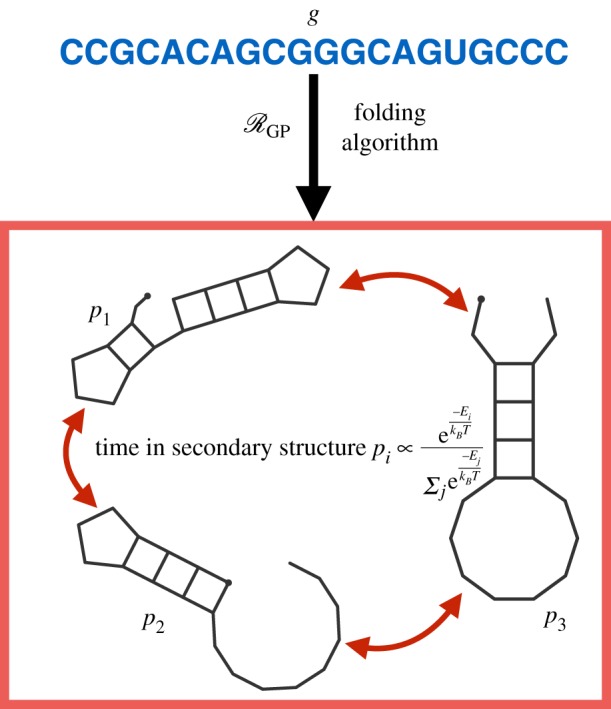
The stochastic RNA model. Thermal fluctuations cause RNA strands to spontaneously unfold and fold again into different secondary structures. In this model, the phenotype is not fixed but switches between secondary structures with free energy below some threshold. The time spent in each secondary structure is dependent on an environmental factor, the temperature T. This phenotypic switching is an example of bet-hedging in the GP-mapping. (Online version in colour.)